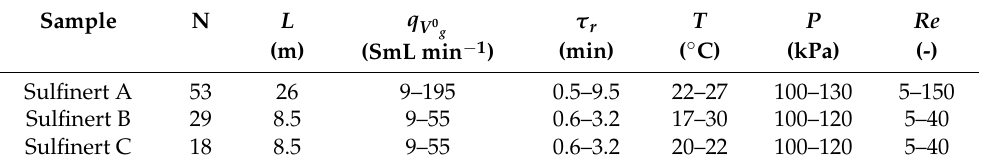
Table 3. Sulfinert ® Number of experiments, pipe lengths, and test condition ranges (residence time,